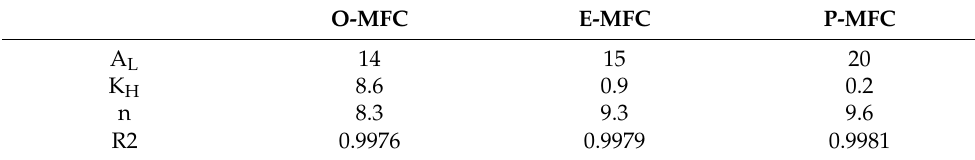
Table 5. Fitting parameters of the water isotherms on MFC films according to Park’s model. Table 5. Fitting Parameters of the water isotherms on MFC films according to Park’s model. O-MFC E-MFC P-MFC O-MFC E-MFC P-MFC A L 14 15 20 A L 14 15 20 8.6 0.2 K H 8.6 0.9 0.2 n 8.3 n 8.3 R2 0.9976 0.9979 0.9981 R2 0.9976 0.9979